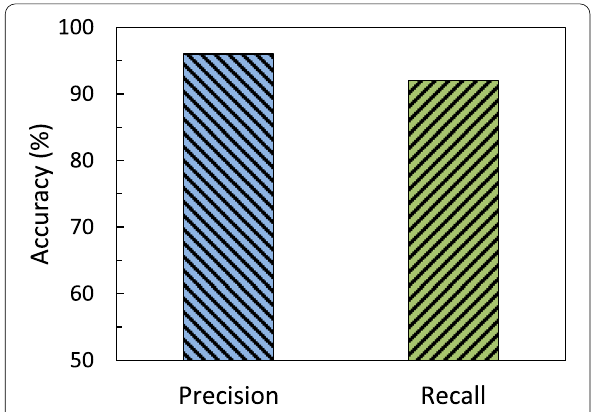
Fig. 6 Accuracy of task identification Fig. 7 Accuracy of task identification under different